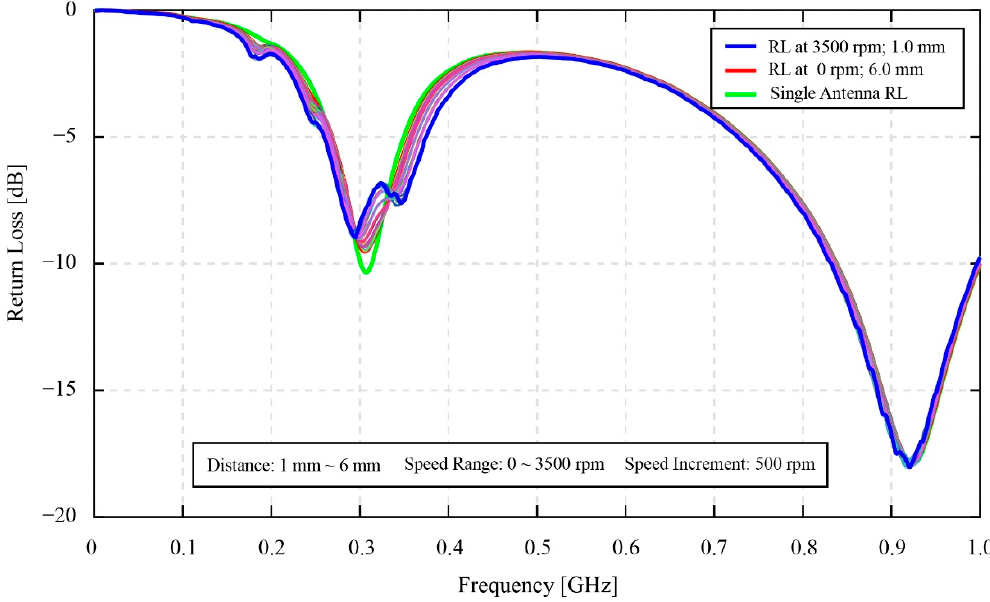
Figure 14. The effect of phase fluctuation at the high speed of the smart gear.